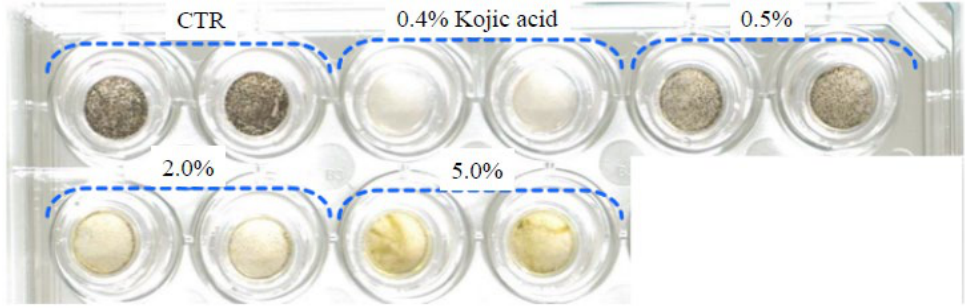
Figure 2. Photograph of three-dimensional human skin model (CTR stands for Control).